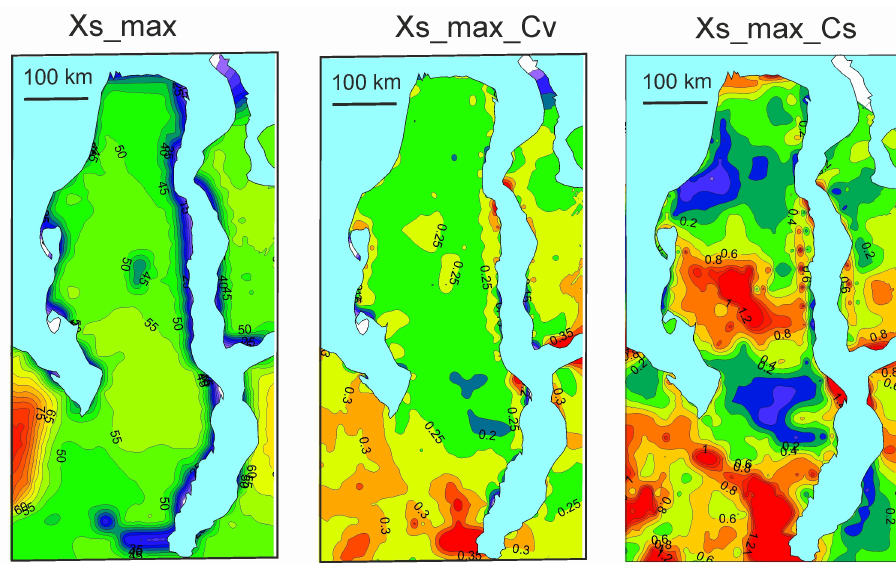
Figure 23. Spatial distributions of mean annual maximum of daily surface runo ff X s_max for the period of snow thaw, its temporal variability C v and skewness C s on the Yamal peninsula.